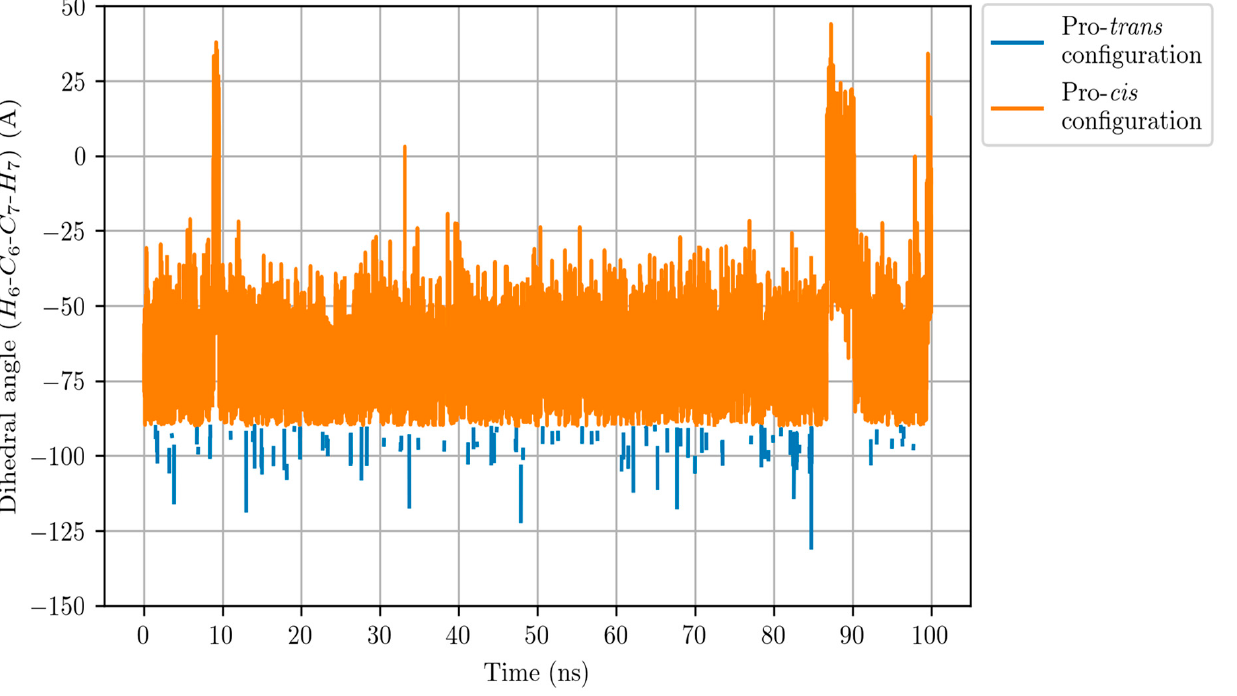
Figure 8. Dihedral angle H 6 -C 6 -C 7 -H 7 along the Molecular Dynamics simulation for the LTA 4 :LTA 4 H Michaelis complex. The pro- cis configuration (orange line) corresponds to | dihedral angle | ≤ 90 ◦ , whereas | dihedral angle | ≥ 90 ◦ indicates a pro- trans configuration (blue line).